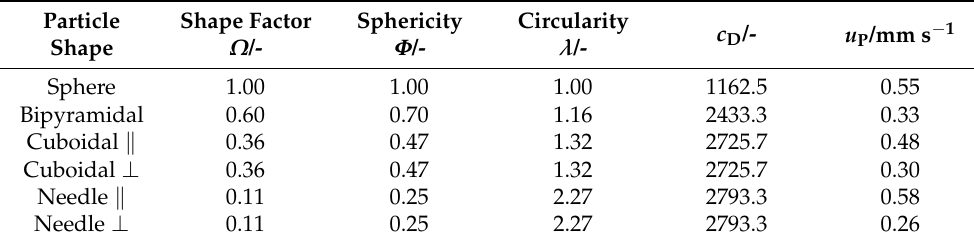
Table 3. Calculated drag coefficients c D and settling velocities u P for the respective particle shapes and orientations. The calculations were carried out for Q tot = 20 mL min − 1 , and a d eq = 64 µ m. The shape factor Ω was calculated according to Equation (23) using the circularity λ